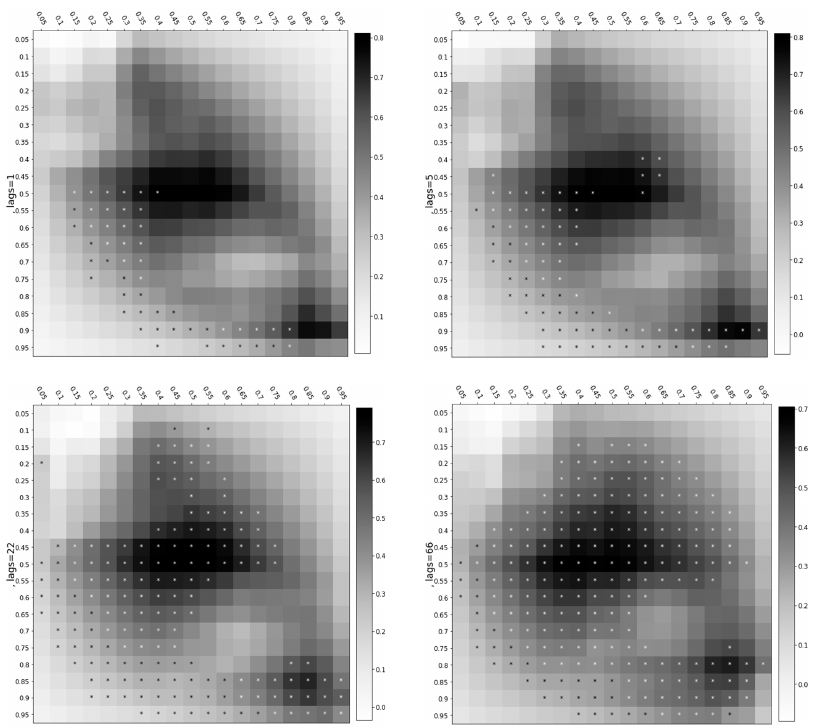
Figure 9. Cross-quantilogram dependence from Moderna to AstraZeneca. Notes: The vertical axis indicates the quantile distribution of Moderna’s stock return, whereas the horizontal axis indicates the quantile distribution of AstraZeneca’s stock return. The white-to-black intensity in the bar indi- cates negative to positive associations. Figure 10 demonstrates the volatility spillover transmission from Moderna to John- son & Johnson. When considering longer memories, more significant squares are ob- served. The results for the short term (the 1 day and 5 days) show a positive correlation under bullish market conditions, whereas the results for the long term show a positive correlation under both the bullish and bearish market conditions. Moderna transmits the most profound effect in the long term.